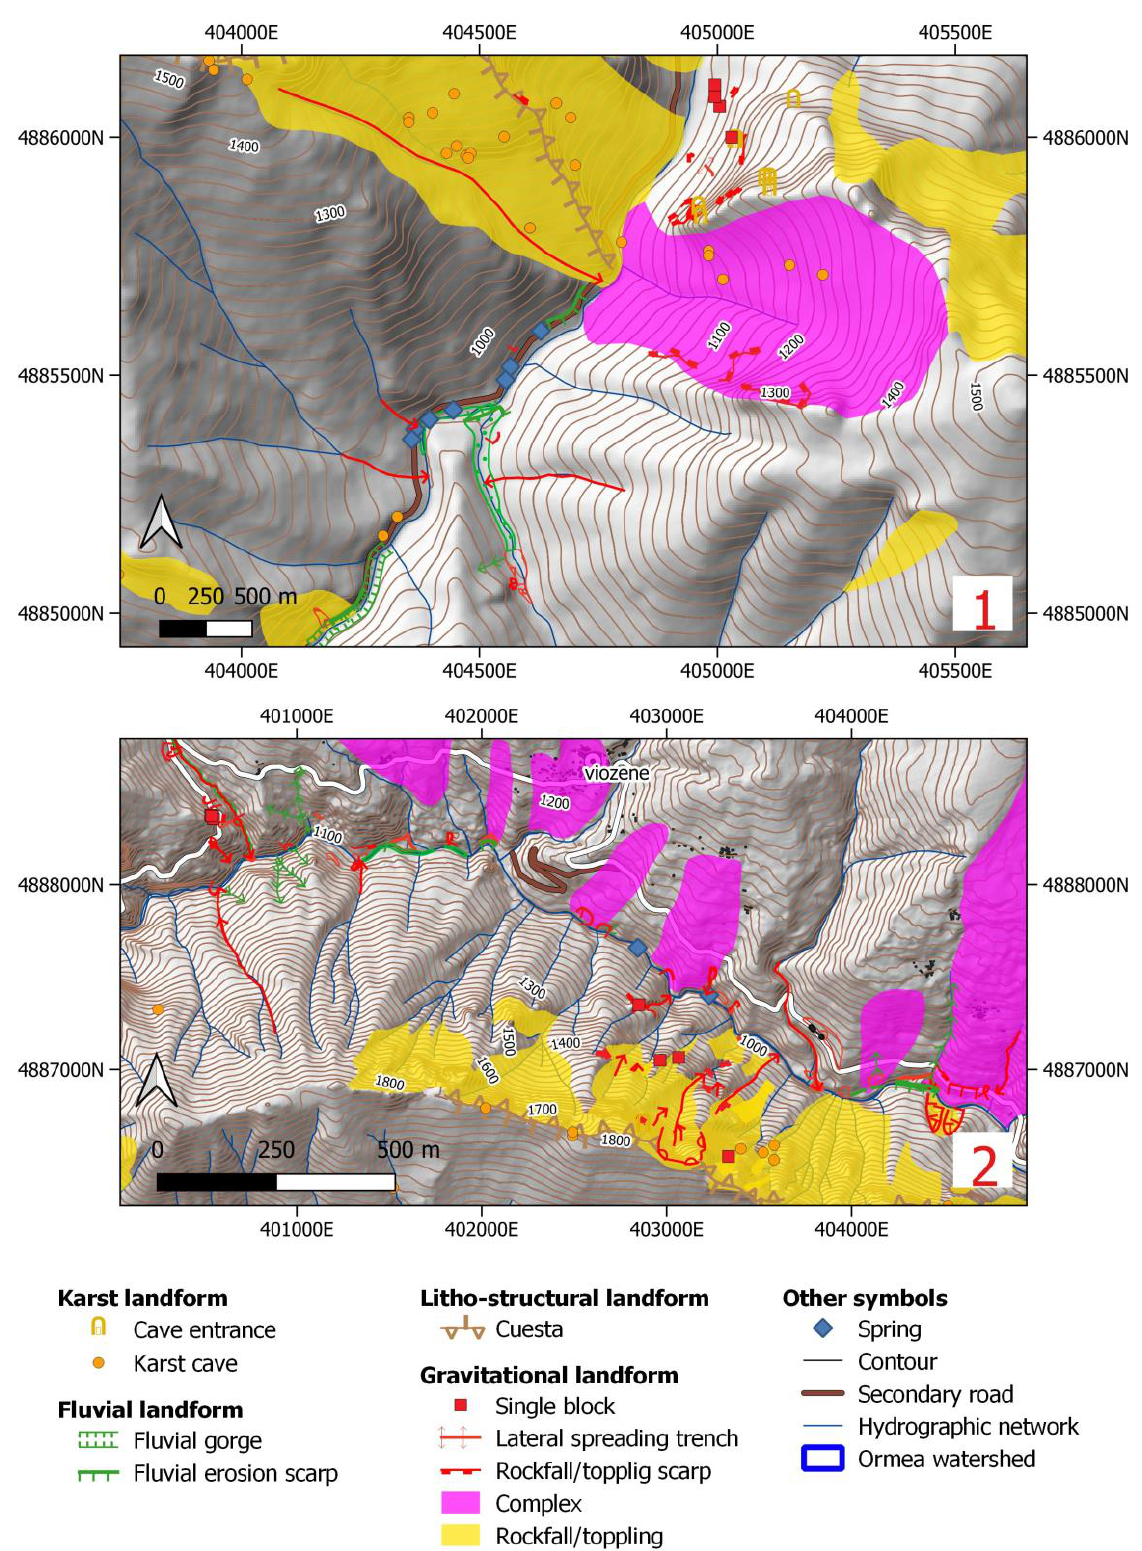
Figure 9. ( 1 ) Geomorphological map of the surroundings of site 1 along the Negrone River; ( 2 ) Geo- morphological map of the surroundings of site 2 along the Tanarello River. Both maps are shown in the previous Figure 8 as red boxes.